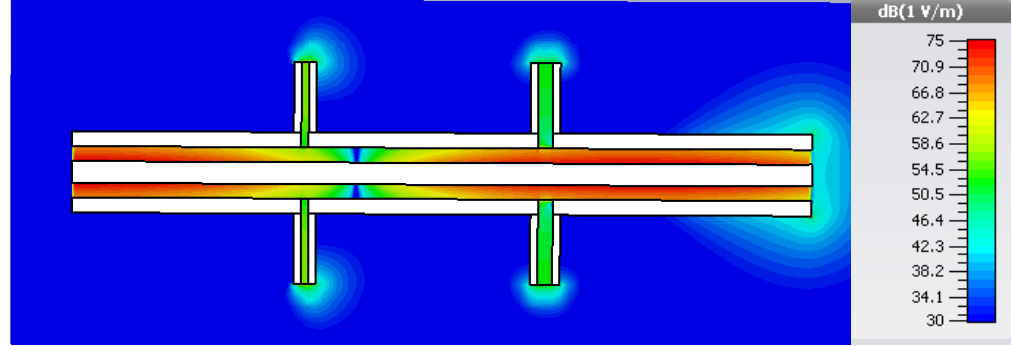
Figure 10. Field snapshot across the line with gaps at a frequency of 2 GHz (spacers made from acetal homopolymer) .